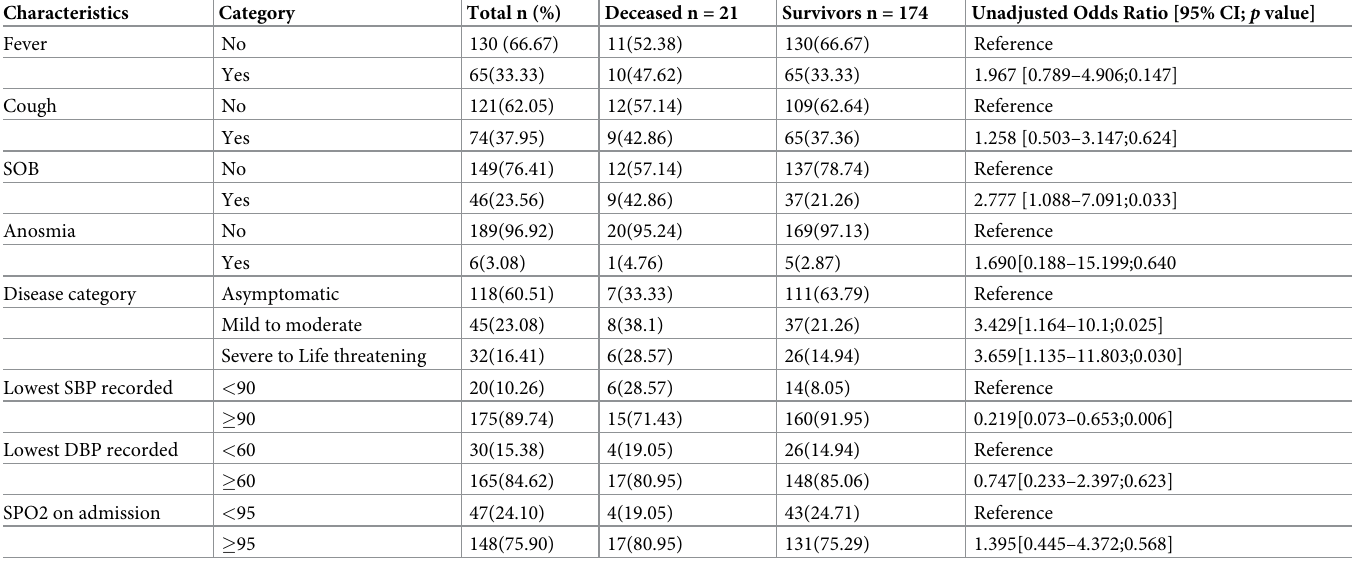
Table 2. Clinical presentation of patients and univariate analysis of mortality risk factors of COVID-19 patients (N = 195) at Kwanar Dawaki isolation center, Kano, Nigeria. Characteristics